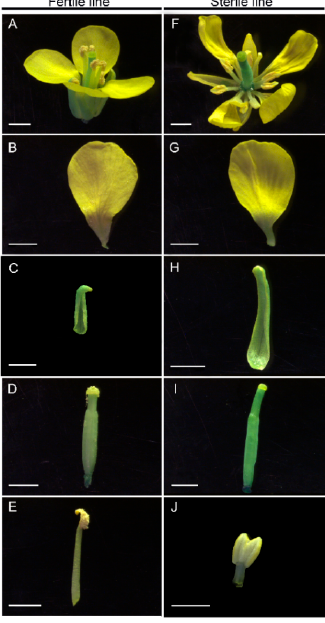
Figure 1. The morphology of flowers of “Bcajh97-01B” (fertile line) and “Bcpol97-05A” (sterile line) of Brassica campestris . Scale bars of 2